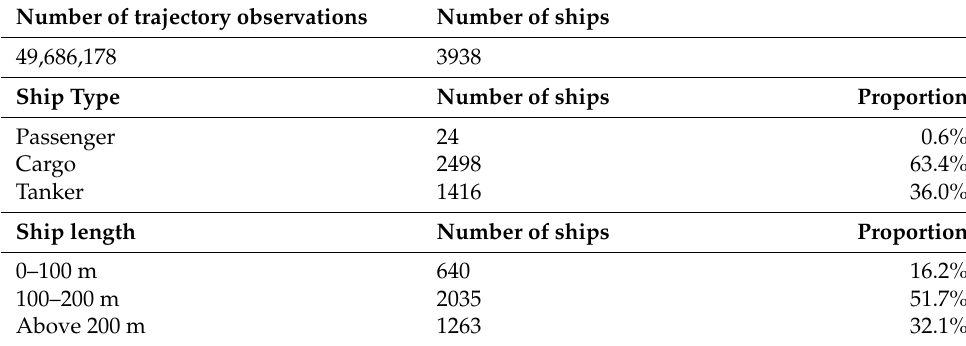
Table 3. AIS data characteristics by ship type and